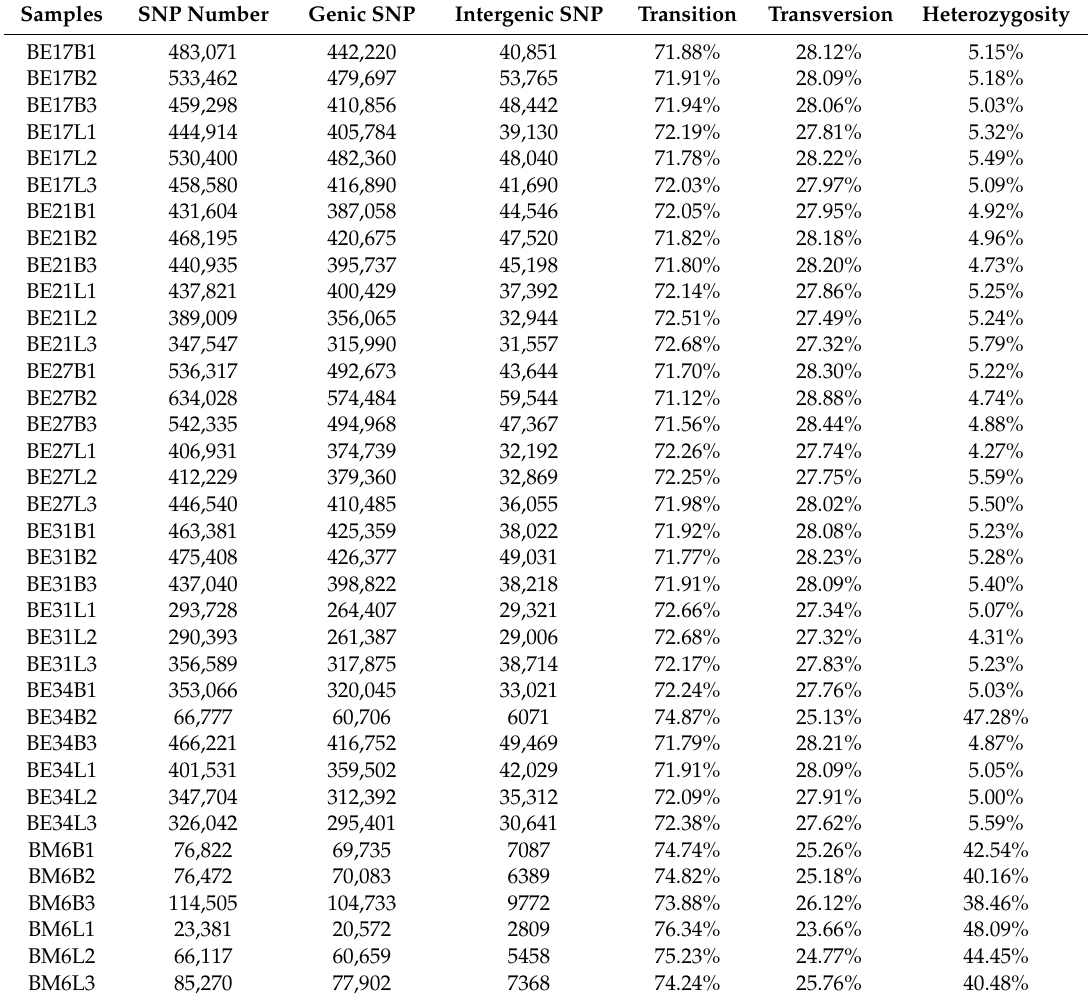
Table 4. Single nucleotide polymorphism (SNP) statistics of each